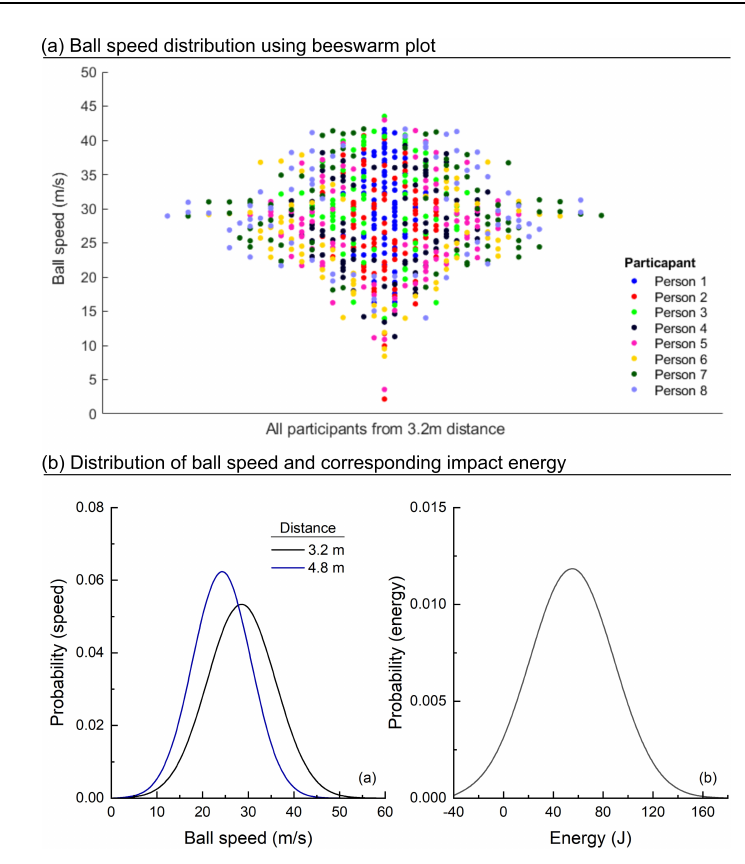
Figure 2. Demonstration of ( a ) beeswarm plot showing all shots from 3.2 m and ( b ) distribution of obtained ball speeds taken from 3.2 and 4.8 m distance to the board and the corresponding impact